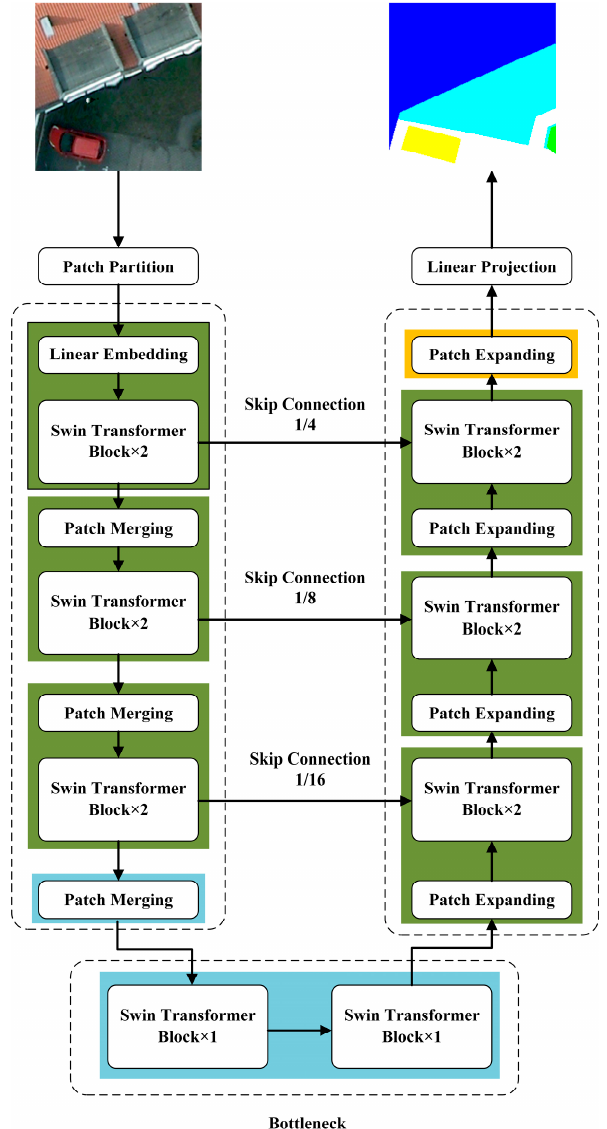
Figure 5. SwinUnet structure.